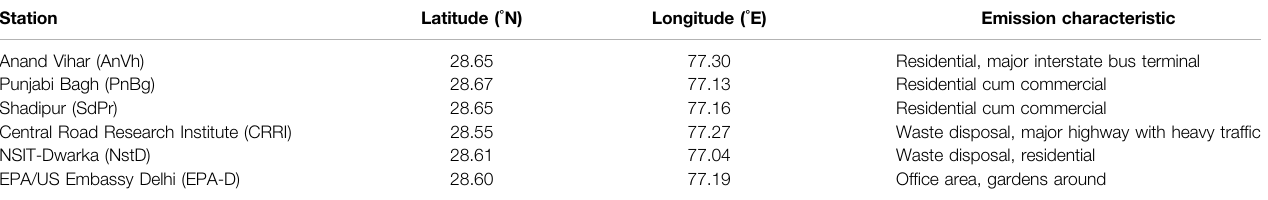
TABLE 2 | Location and characteristics of sites chosen for this study. Station